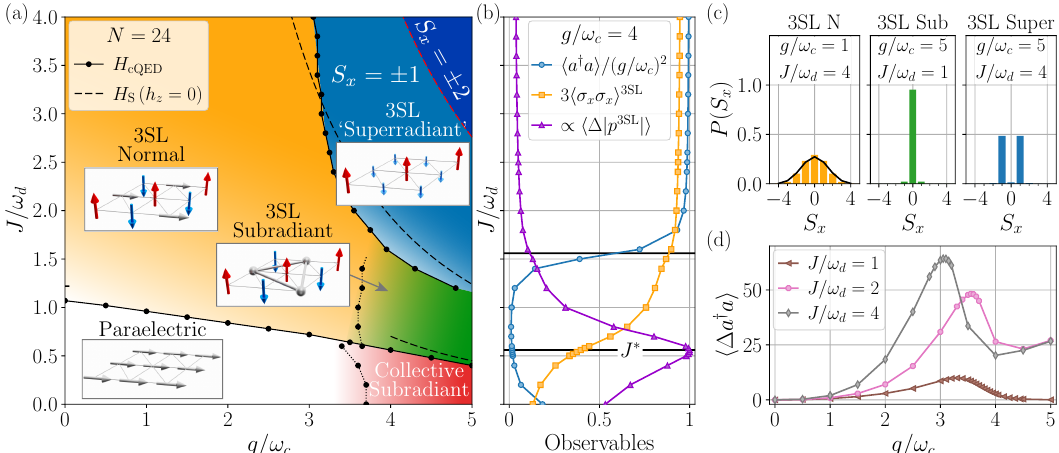
Figure 4: Cavity QED ground states on the triangular lattice. (a) Phase diagram of H for a system of N = 24 dipoles. The insets show illustrations of the spin config- cQED urations in the corresponding phases. Solid (dotted) lines indicate phase transitions (crossovers). The dashed lines show phase boundaries estimated from the effective = 0 [ Eq. (6) ] and show good agreement with the exact phase spin model H with h z S boundaries from H for large g /ω . The red dashed line indicates a transition c cQED between superradiant phases with different values of S , which appears for larger x = 0 and N = 36 [ see also lattices. The shown boundary is estimated for H with h z S = 4. The correlations 〈 σ σ 〉 3SL reveal Fig. 5 ] . (b) Observables for a cut at g /ω c x x spin ordering above a critical interaction strength J ∗ ( g ) which is estimated by a peak in 〈 ∆ | p 3SL |〉 . The photon number 〈 a † a 〉 clearly discriminates the transition between the sub- and superradiant 3SL phases. (c) Polarization histograms in the 3SL nor- mal, subradiant, and superradiant phases (from left to right). The solid line in the left panel shows, as a comparison, the expected histogram for a single paraelectric sublattice. (d) Photon number fluctuations. The maxima are used to track the phase boundaries to the 3SL superradiant phase, where the fluctuations show a non-zero